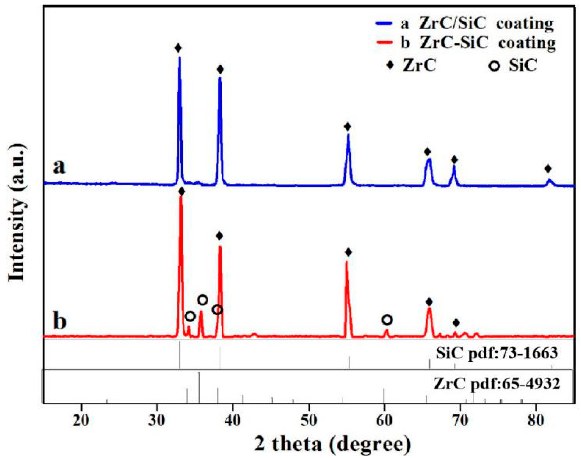
Figure 2. The XRD results of ZrC/SiC and ZrC-SiC coatings.